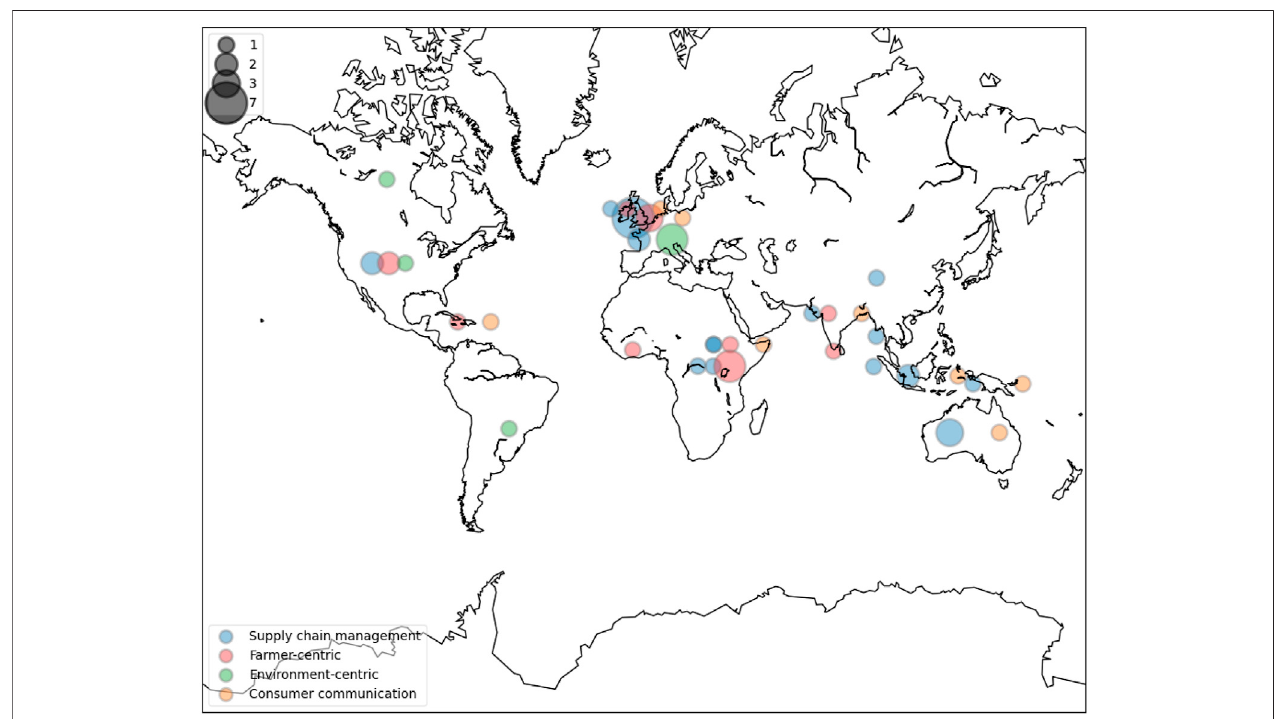
FIGURE 2 | Overview of the application themes and geographical distribution of the investigated use cases (updated in October 2020 and data visualisation by Philippe Debie). The sizes of the circles correspond to the number of use cases studied and the position of the circles showing the location of the headquarters of the leading actors in the